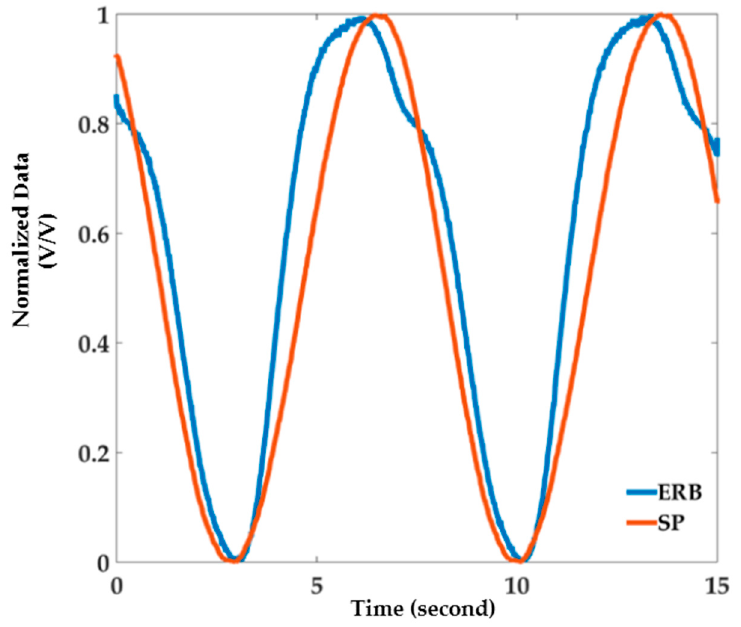
Figure 3. Normalized ERB voltage versus Normalized SP voltage.